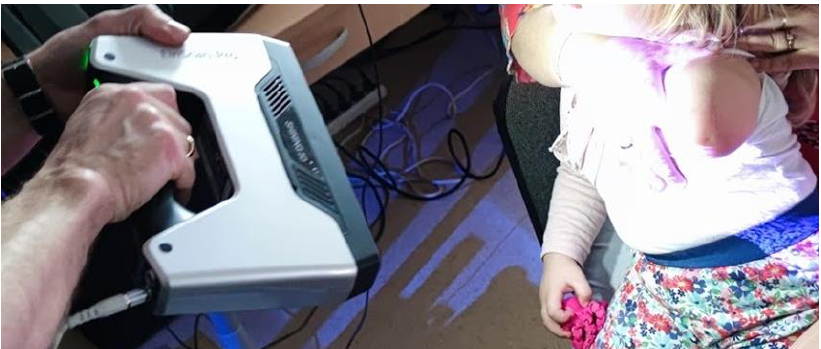
Figure 4. Manual 3D scanning of the patient’s stump .